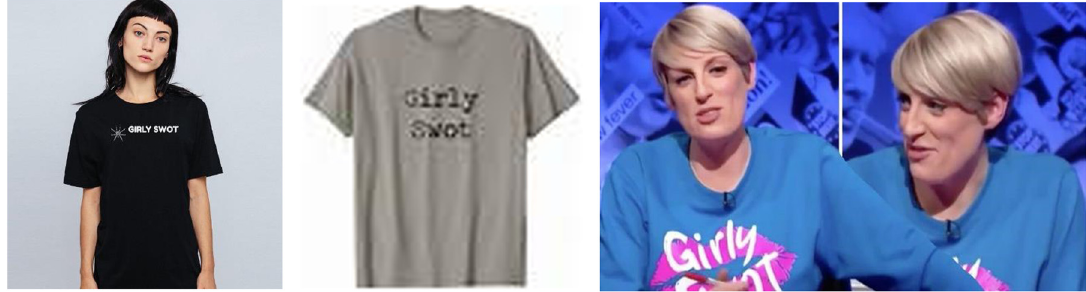
Figure 1: “ Girly swot ” reclaimed: T - shirts.